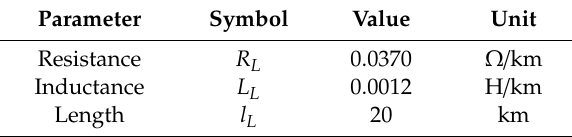
Table A4. Transmission lines